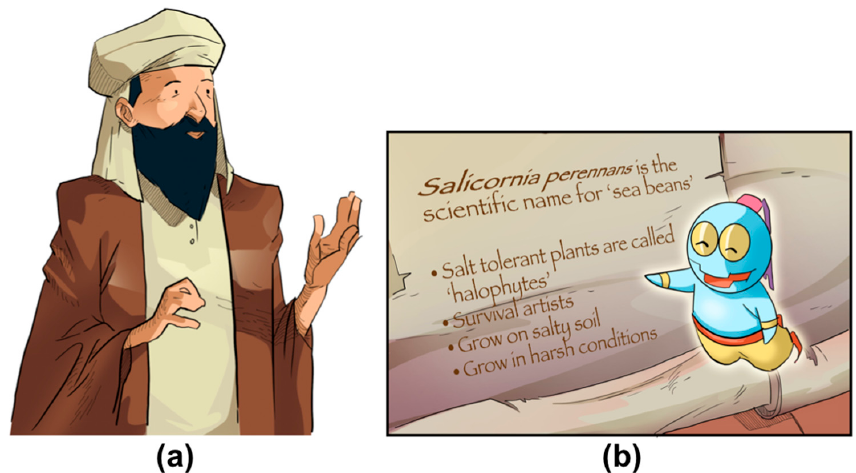
Figure 3. The sultan ( a ) and the science jinn explaining the technical term “halophytes” ( b ).